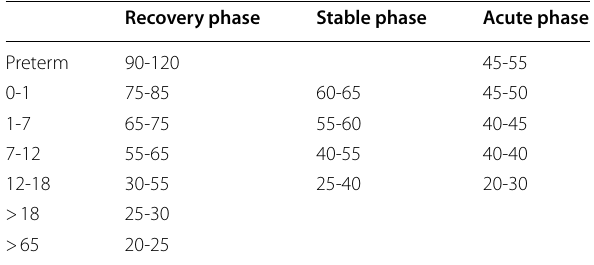
Table 3 Consensus recommendations for calculations of